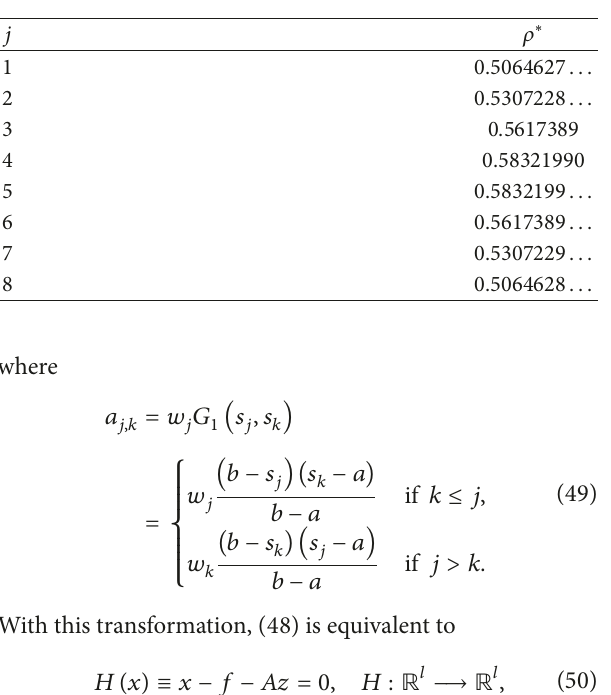
Table 3: Approximation of solution of (52). Table 4: Absolute error obtained by